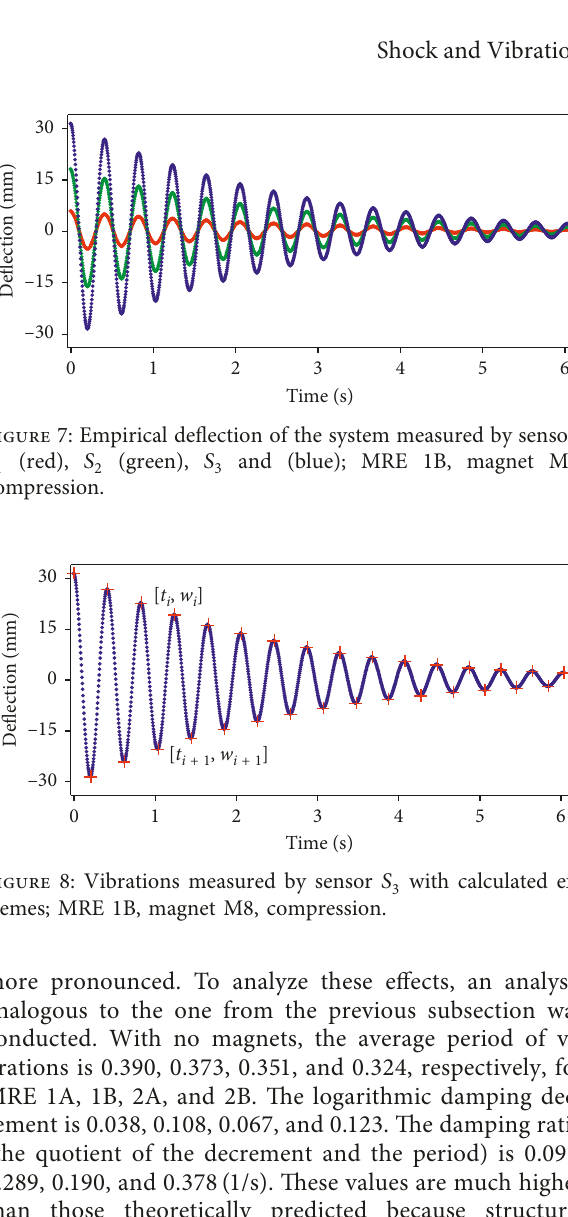
3 with calculated ex-